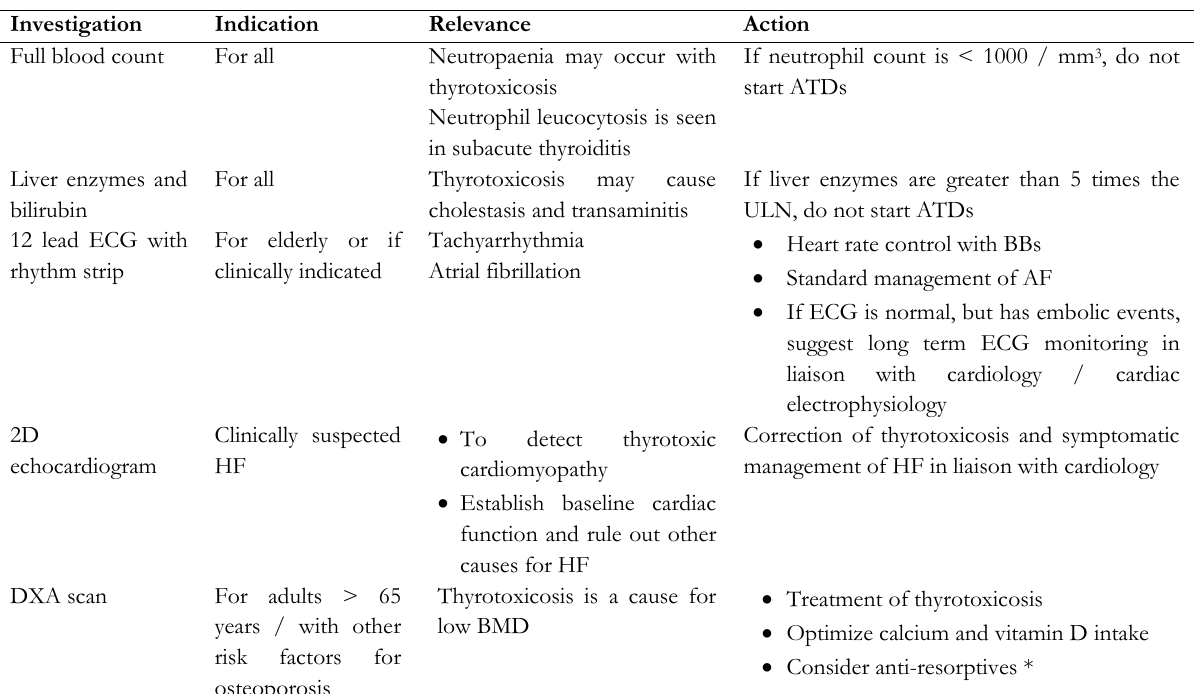
Table 3.5. Supportive investigations for evaluation of